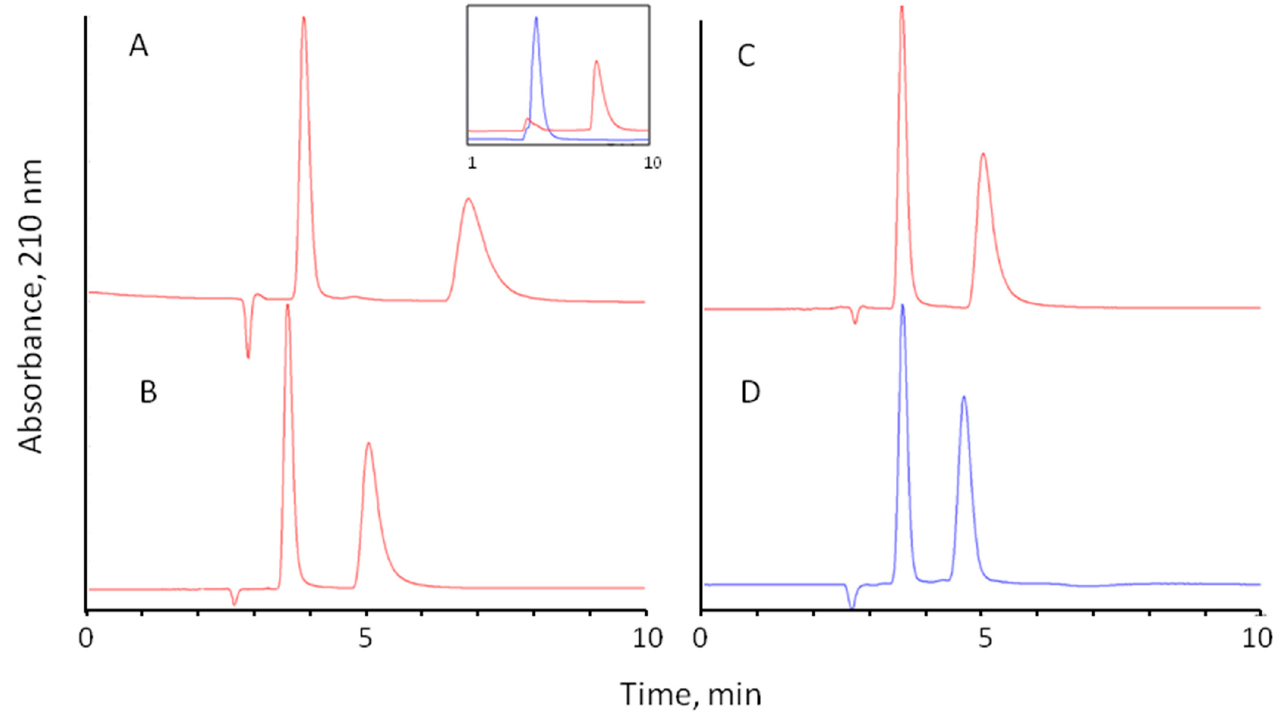
Figure 5. Separation of D,L-methionine on Chloro-E-CSP column with different mobile phases: ( A )—0.1% perchloric acid (pH 4.5 adjusted with NH 4 OH)—methanol (90:10); ( B )—water—methanol (90:10); ( C )—water; ( D )—0.1 M sodium phosphate (pH 4.5)—methanol (90:10). Column: 250 × 4.0 mm ID, flow rate 0.7 mL/min, temperature 25 °C; detection at 220 nm, injection volume 10 µL. Insert: separate chromatograms obtained for L-Met (blue chromatogram) and D-Met (red chromatogram) under the same conditions.